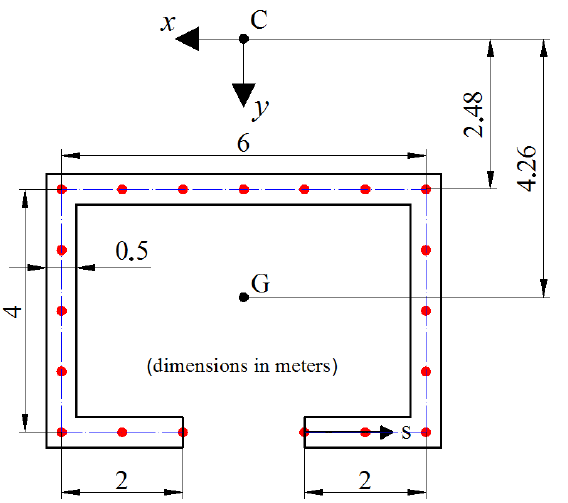
Figure 14: Dimensions of the open shear-wall no. 6.